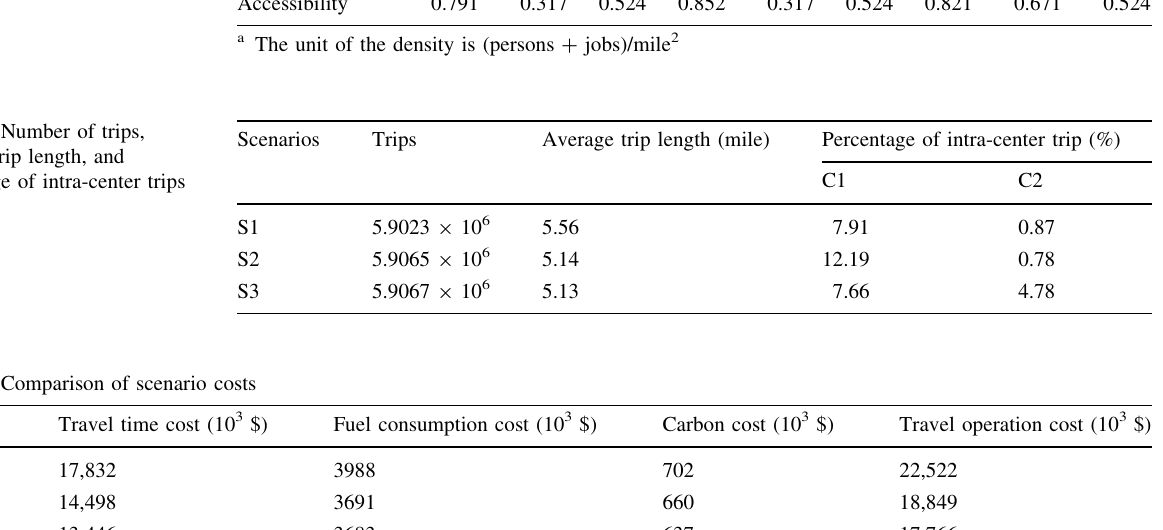
Figure 7a visualizes VMT and VHT by scenario. Compared with S1, there are 7.39 and 18.74% decrease in VMT and VHT, respectively, in S2, and 7.58 and 24.68%